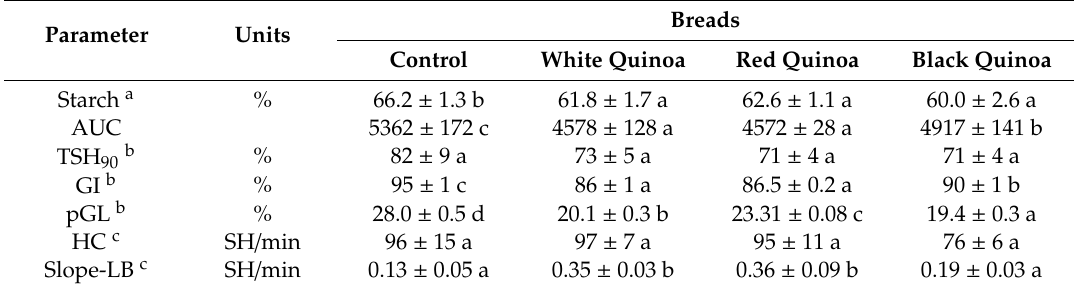
Table 5. E ff ect of quinoa flour addition on glycaemic index and glycaemic load.